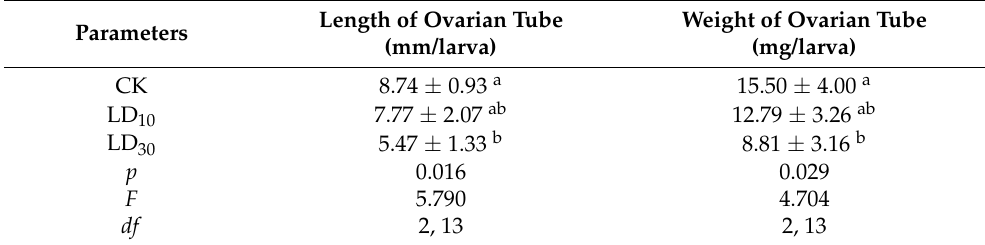
Table 10. Sublethal effect of fluxametamide on the length and weight of the ovarian tube of C. suppressalis.